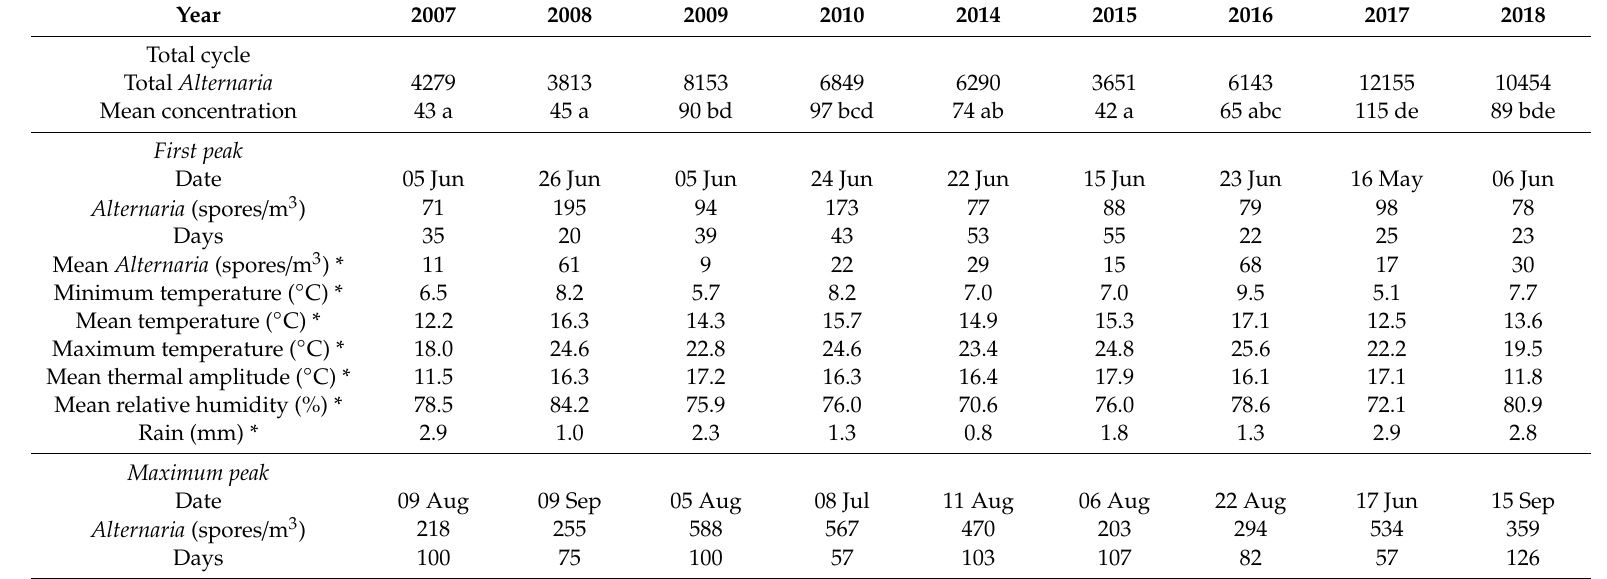
Table 1. Airborne Alternaria spores in the environment crop by year. Values of the first and maximum peak of Alternaria with the corresponding date and number of days from sowing. Average values of the environmental conditions given up to the first peak of Alternaria